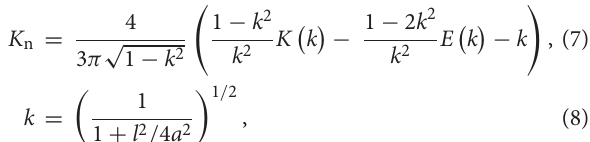
= 0.235 µ H calculated by ∼ 2 (cid:127) = 10 % of the L a used in (A) . ±